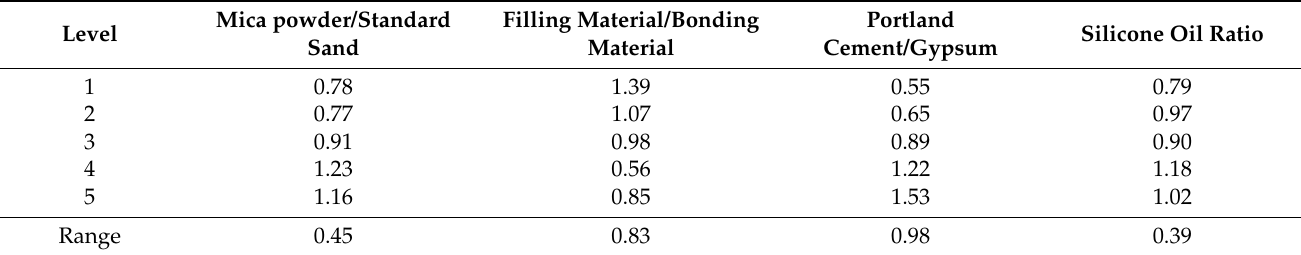
Table 7. Range analysis of compressive strength MPa.